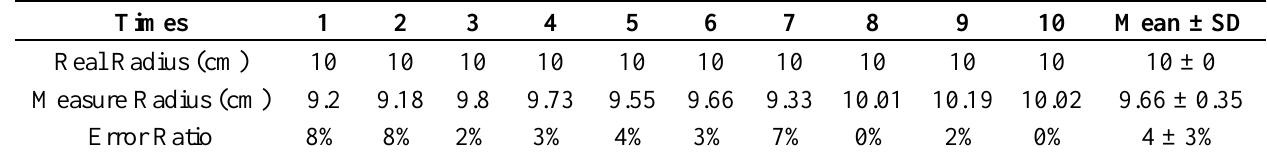
Table 2. The mean and standard deviation values of the radius measured by CPCMS.